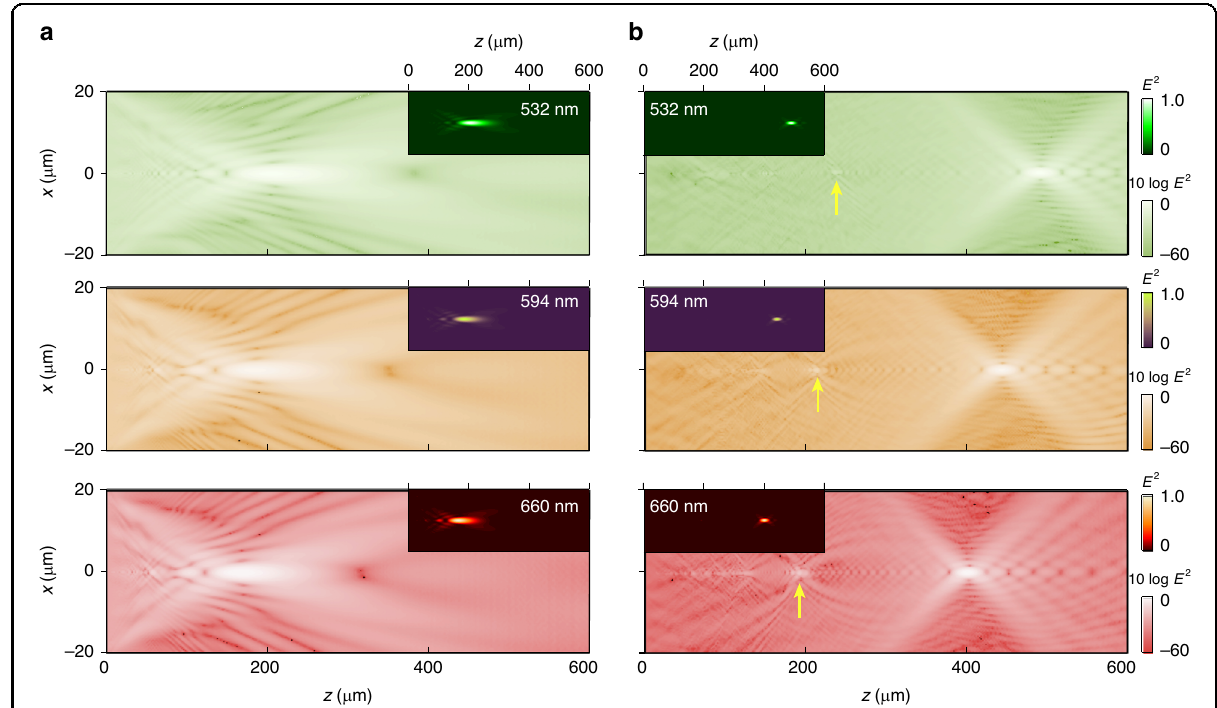
Fig. 4 Light intensity pro fi le of the PB-metalens and the PR-metalens obtained from the measured phase distribution. a Intensity pro fi les of the focal spot in the x - z plane of the PB-metalens and its logarithm. b Intensity pro fi les of the focal spot in the x - z plane of the PR-metalens and its logarithm at 532 nm, 594 nm and 660